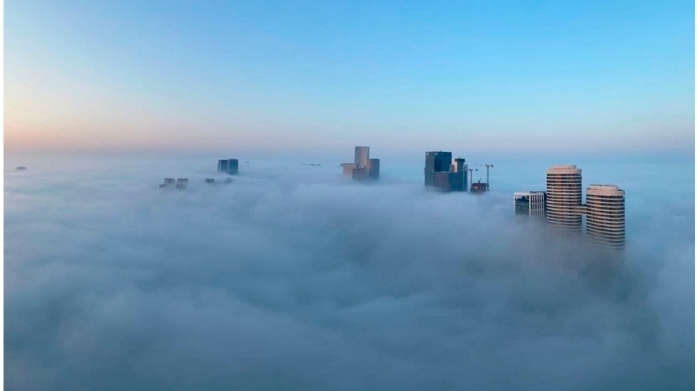
Figure 1. Heavy fog covers Tel-Aviv buildings, 3 January 2021, during early morning hours [6].